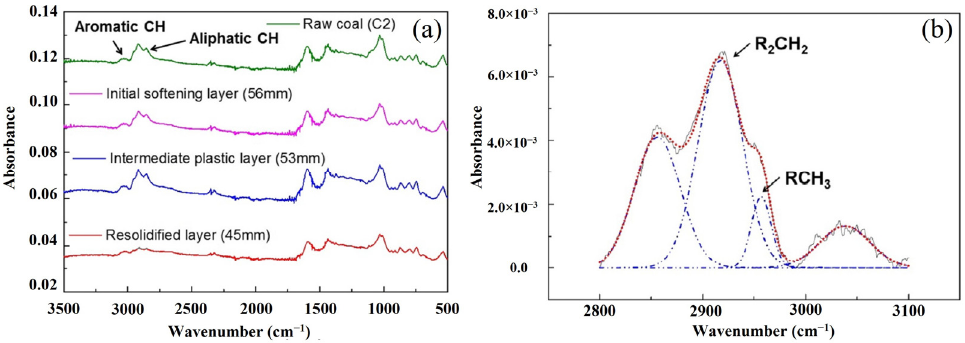
Figure 2. The FTIR spectrums of residue samples in the coke oven: ( a ) the residue sample in different positions of the coke oven; ( b ) an example of deconvolution of the spectra [57]. Raman Spectroscopy (Raman)